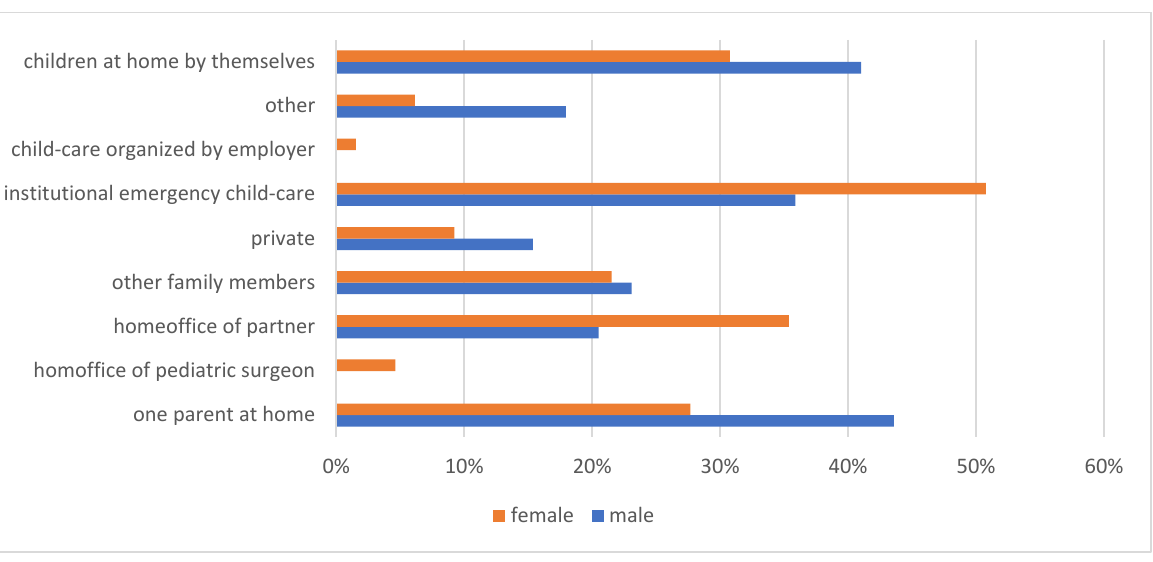
Figure 3. Childcare before the pandemic. The percentage exceeds 100% in the age groups because childcare for one child can be arranged in various ways.